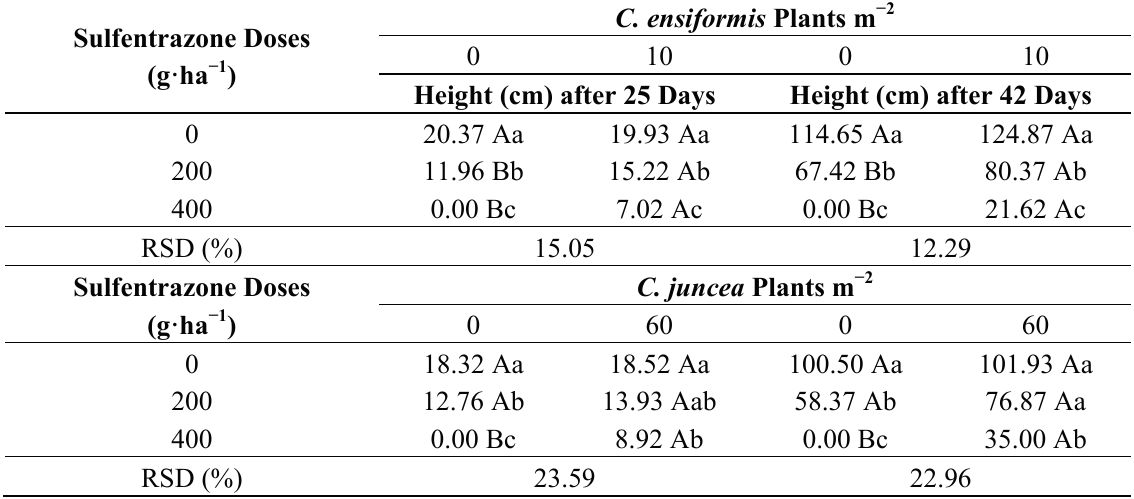
Table 1. The height of Pennisetum glaucum at 25 and 42 days, sown after the prior cultivation of Canavalia ensiformis and Crotalaria juncea in soil contaminated with two doses of the herbicide